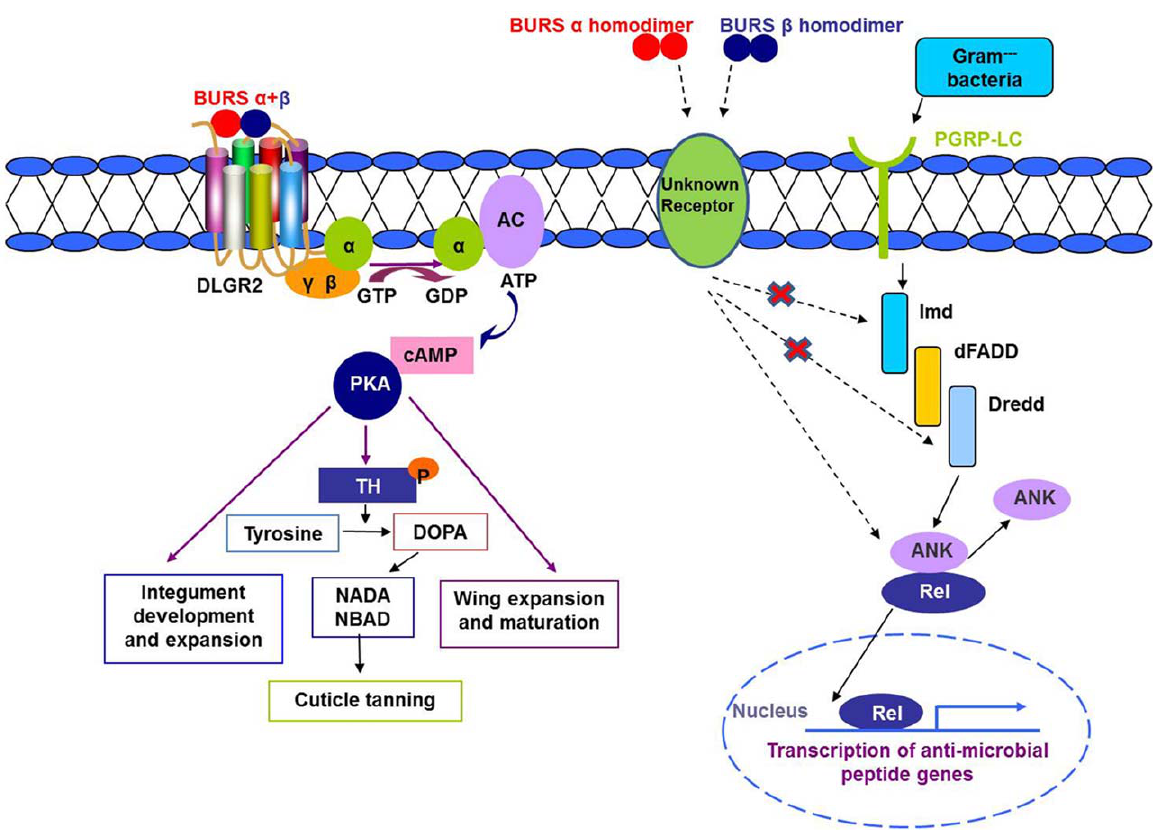
Figure 7. A partly hypothetical model of bursicon signaling pathways, showing the known interaction between burs a 2 b heterodimer and its receptor, DLGR2, and interactions between burs a 2 a and burs b 2 b homodimers and a hypothesized receptor(s) leading to the transcription of AMP genes. The model also shows the Imd pathway and the position of Relish. Once activated, Relish translocates into the nucleus, where it promotes transcription of genes encoding